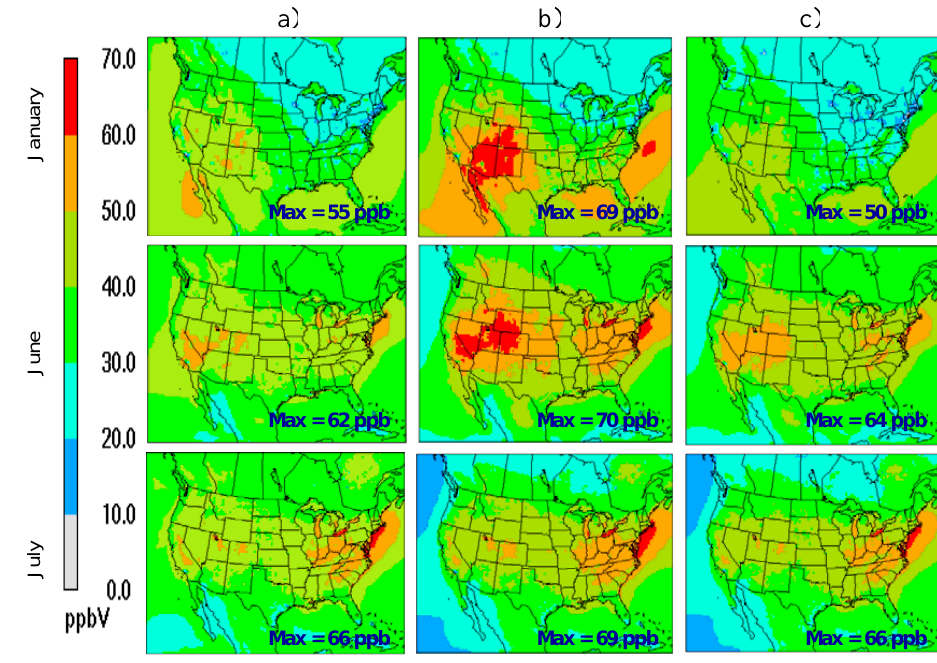
Fig. 9. Comparisons of monthly average ozone concentrations in January, June and July from CMAQ outputs; (a) Profile-BC (left), (b) ORDY-BC (middle), and (c) Tropo-BC (right). The maximum concentration within the domain is shown at the bottom of right hand corner.